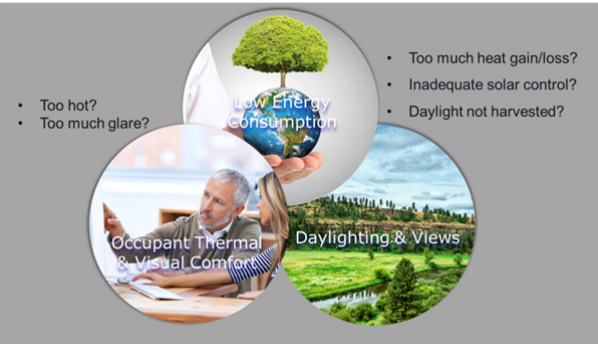
Fig. 1 A pictorial representation of the Green Building Challenge. The challenge is how to optimize both energy efficiency and daylight and views without compromising occupant